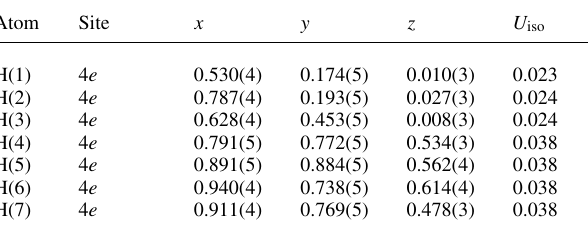
Table 2. Atomic coordinates and displacement parameters (in Å 2 )